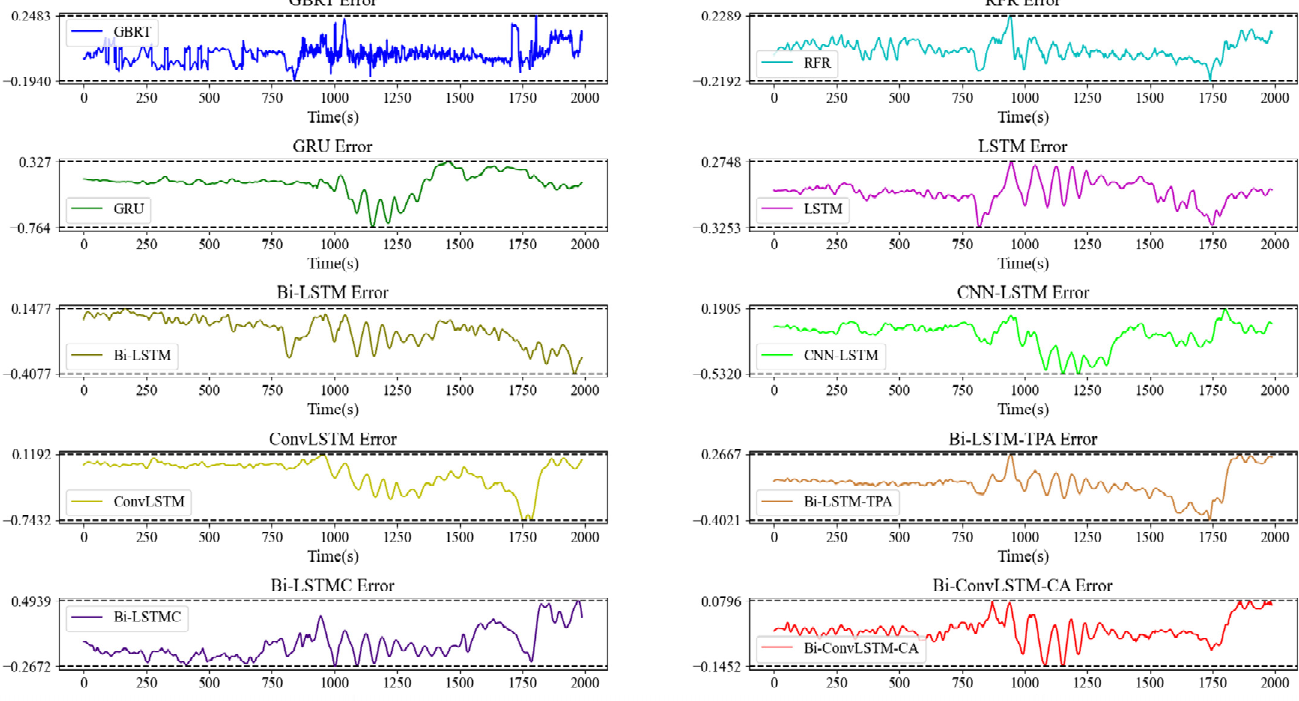
Figure 13. Prediction errors of various models.